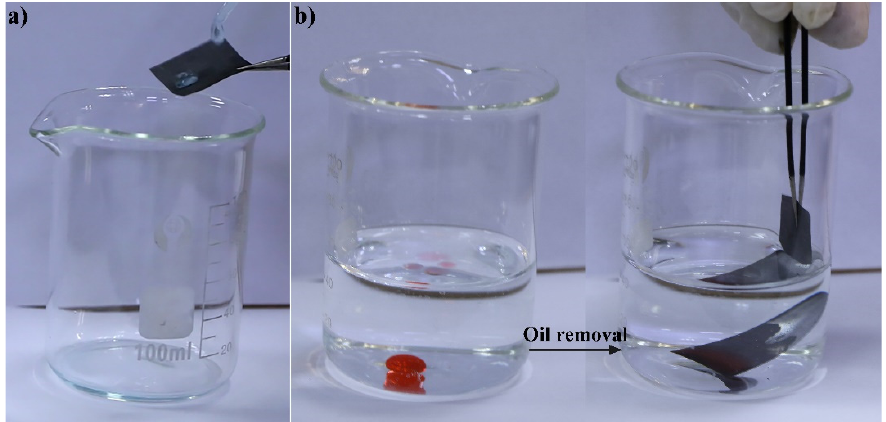
Figure 6. Images of ( a ) continuous water droplets bouncing off the surface of CS-coated mesh, and ( b ) oil removal process of the fabricated mesh towards the CCl 4 -in-water mixture. ( b ) oil removal process of the fabricated mesh towards the CCl 4 -in-water